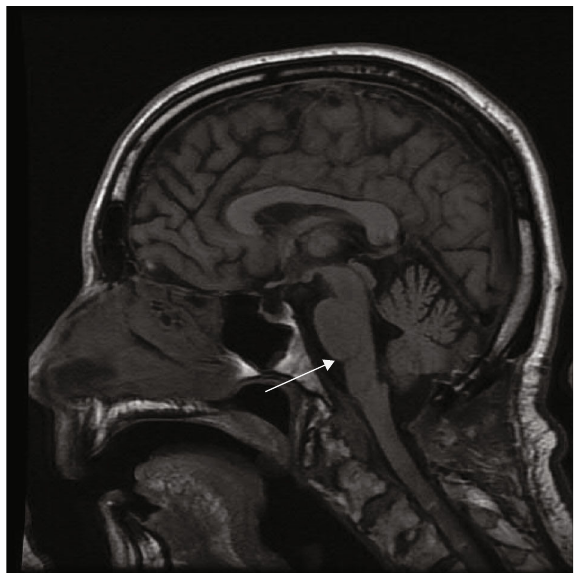
Figure 6: Postoperative MR brain T1 FLAIR sagittal image demonstrates resolution of the cervicomedullary compression and caudal medullary